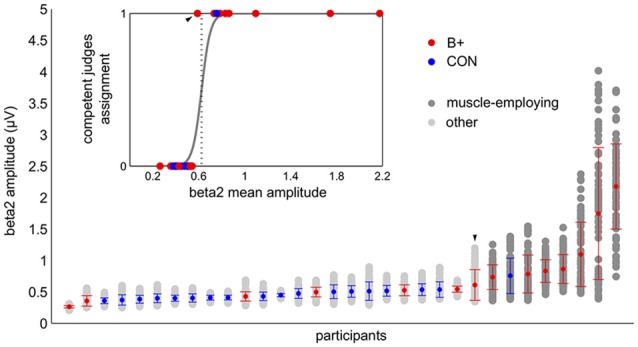
Automatic classification of the participants based on beta2 amplitude: k-means (main graph) and logistic regression (insert). In the main graph the light and the dark gray dots correspond to the values of the beta2 amplitude from the single training blocks. The vertical bundles of dots display all of the training data of the individual participants, which constituted the basis for k-means clustering. The graph summarizes the results of the k-means classification: dark gray dots—muscle employing participants, light gray dots—others. The colored dots (in both graphs) correspond to the grand average beta2 of the person with red indicating the participants from the beta up-training group (B+) and blue those from the control group (CON). The participants are sorted by the increasing average of their beta2 amplitude. The error bars represent standard deviations. The embedded graph shows the result of a logistic regression analysis supervised by competent judges group assignments (code 1—muscle employing participants, code 0—others). The dotted vertical line marks the decision criterion. The participants whose grand mean exceeded this value were classified as muscle employing. Both automatic methods provided concurring results. Note the ambiguous case which was classified by competent judges as muscle employing but did not reach the decision criterion in both automatic classifications (marked on the graph with the arrow head).